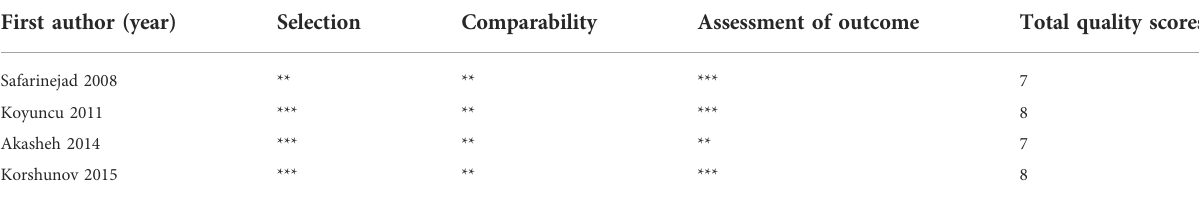
TABLE 2 Newcastle-Ottawa Scale for the included studies.